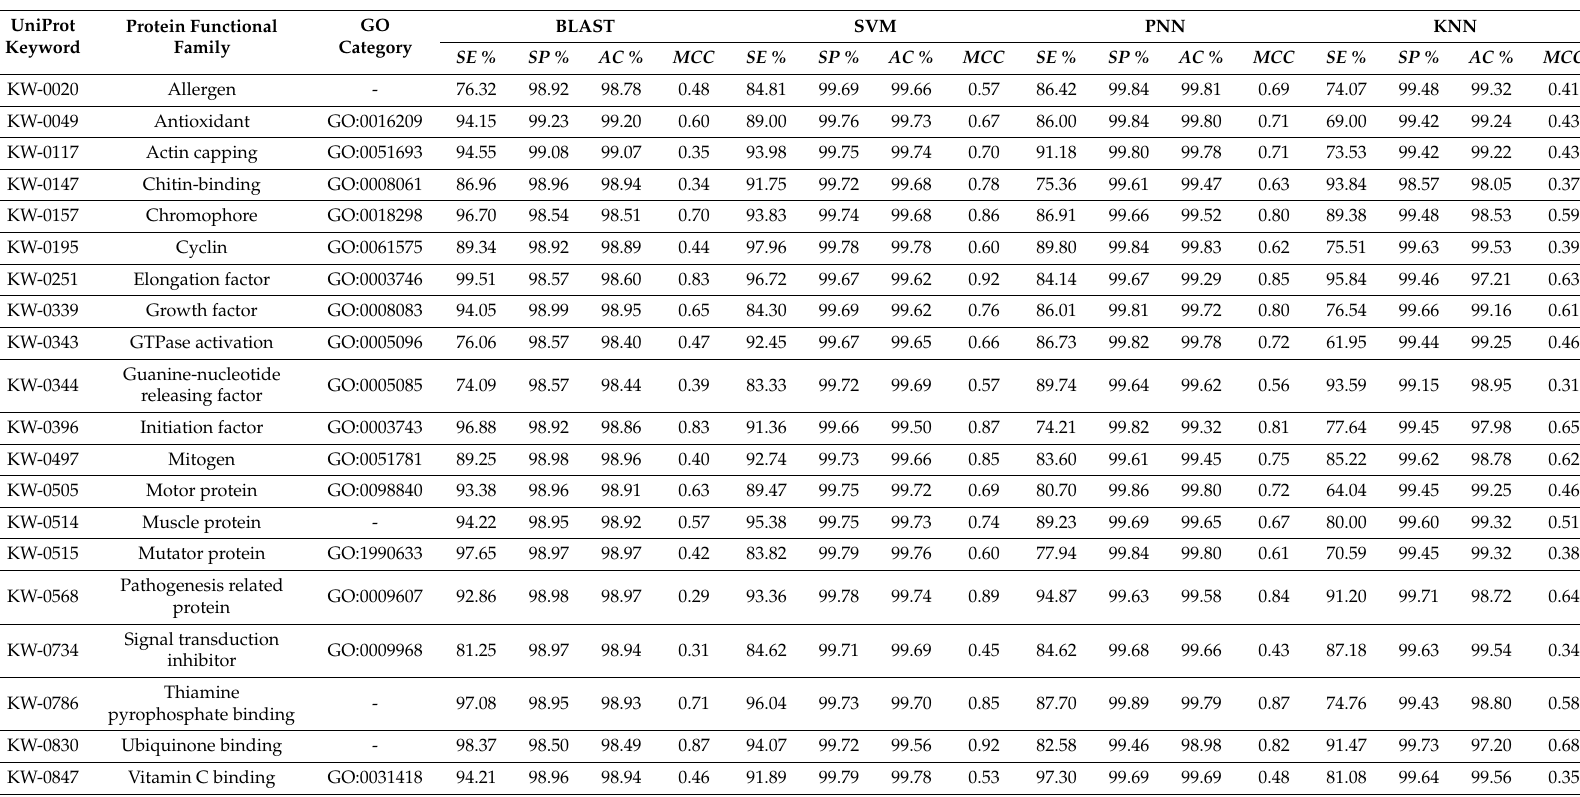
Table 1. The performance of four protein function prediction algorithms assessed by four popular metrics: sensitivity ( SE ), specificity ( SP ), accuracy ( ACC ) and Matthews correlation coefficient ( MCC